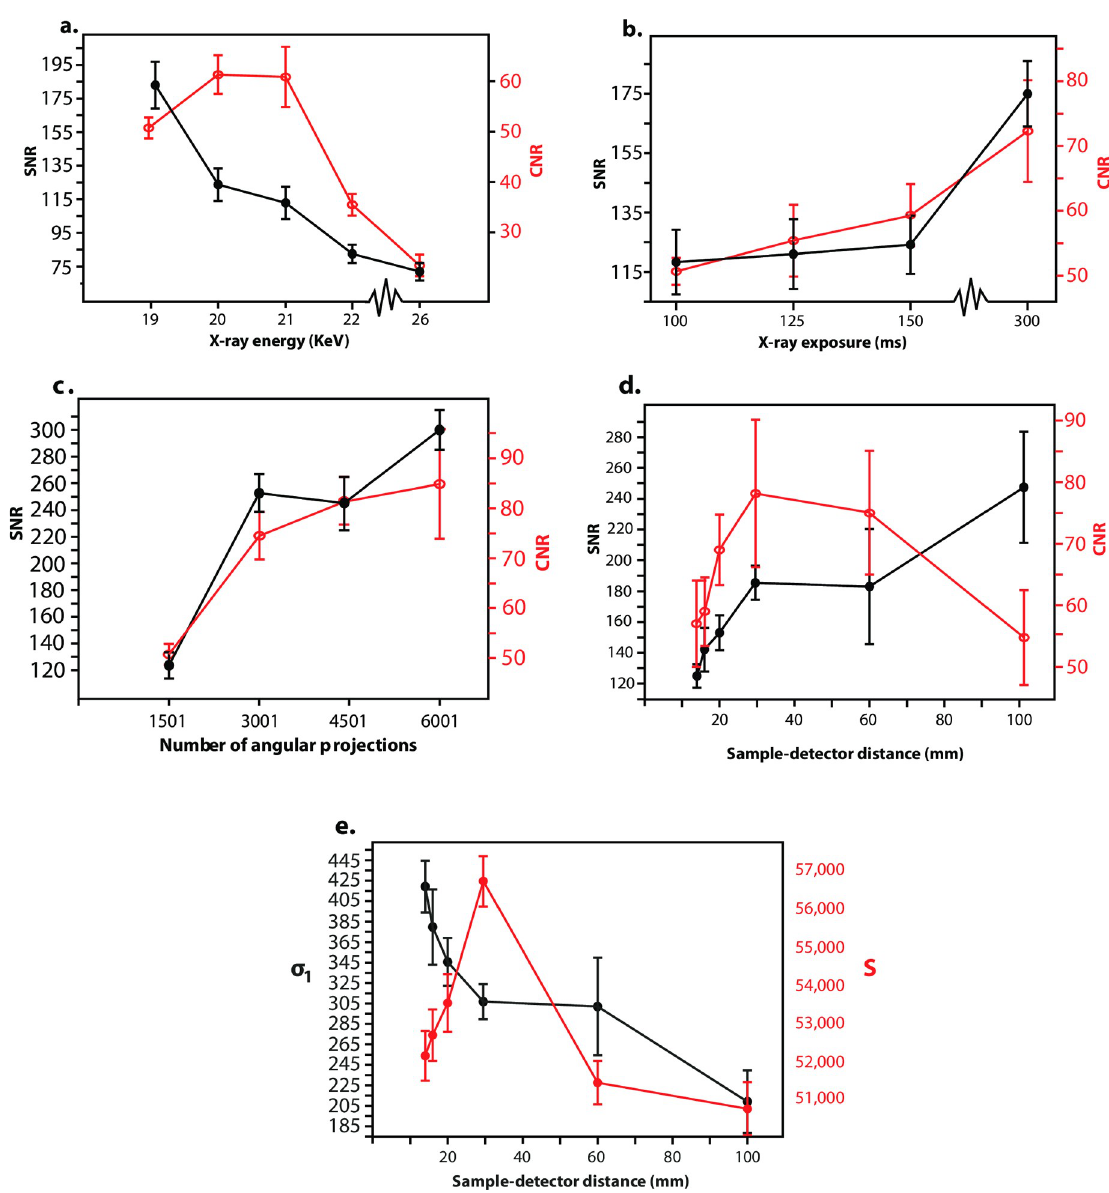
Fig 4. SNR and CNR for sweep of experimental settings for PPCI through SR CT. Data shown is from specimen l56. ( a ) SNR (shown in black) and CNR (shown in red) values for different X-ray energies. ( b ) SNR and CNR values for different exposure times. ( c ) SNR and CNR values for different numbers of angular projections. ( d ) SNR and CNR values for different sample-to-detector distances. ( e ) Relationship between the standard deviation of background ( σ b − shown in black) and the mean of cementum signal ( g with increasing sample-to-detector